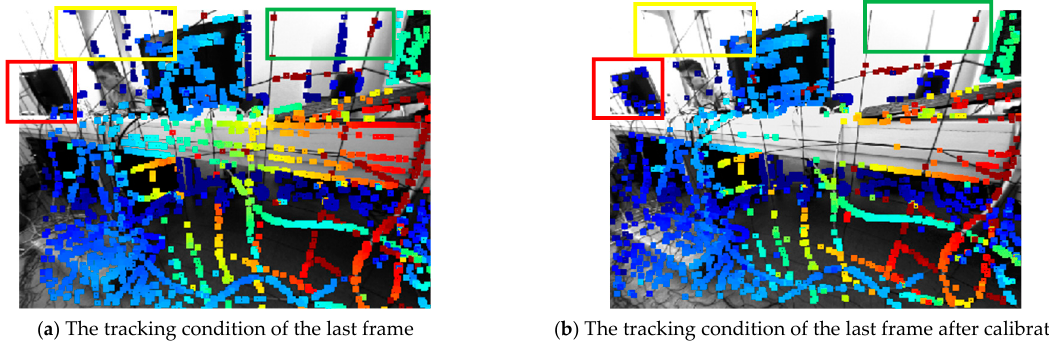
Figure 10. The exposure condition and pixel tracking of TUM mono dataset sequence 04.